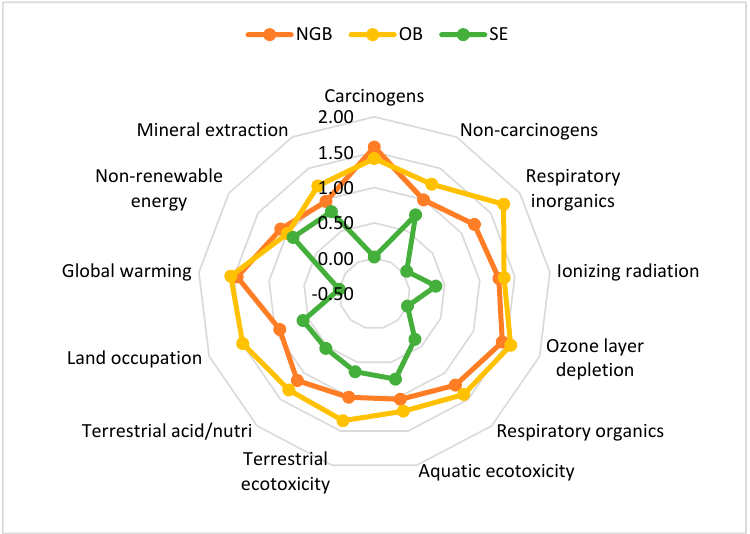
Figure 6. Comparing the relative impact assessment of the technologies. The different factors are made dimensionless by dividing each value by the average value of the factors.